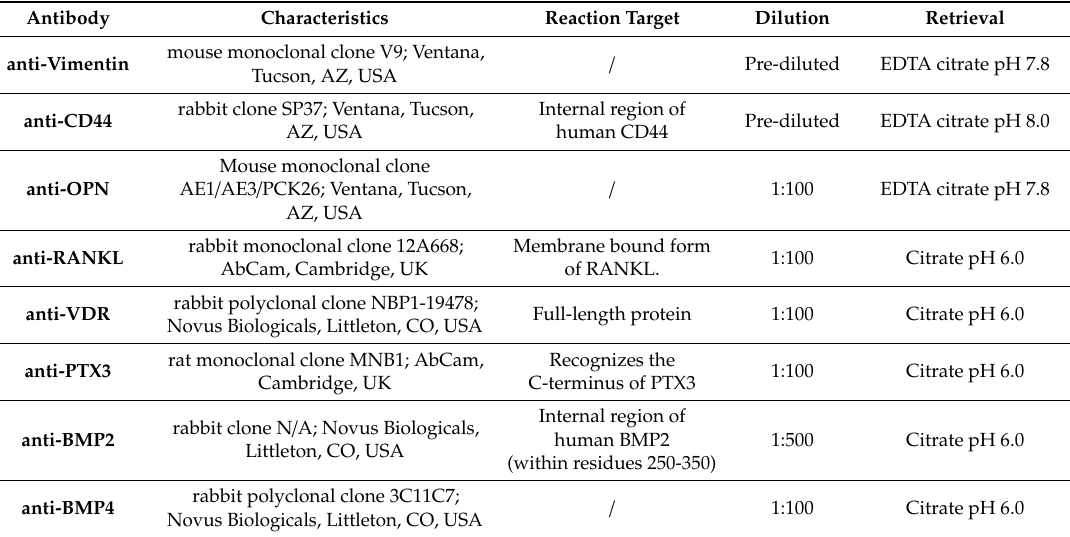
Table 2. List of primary